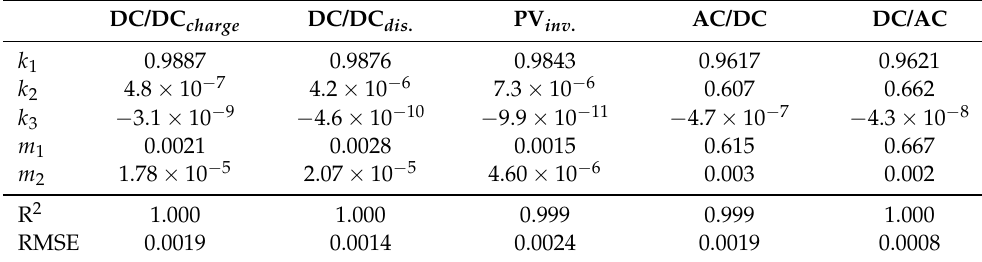
Table A2 presents the numerical values for (8) to represent the converter efficiency characteristics. Figure 5 visualises the results as a function of converter loading. Table A2. Numerical values for the modelled converters to be used in